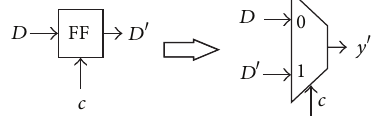
Figure 1: Flip-flop